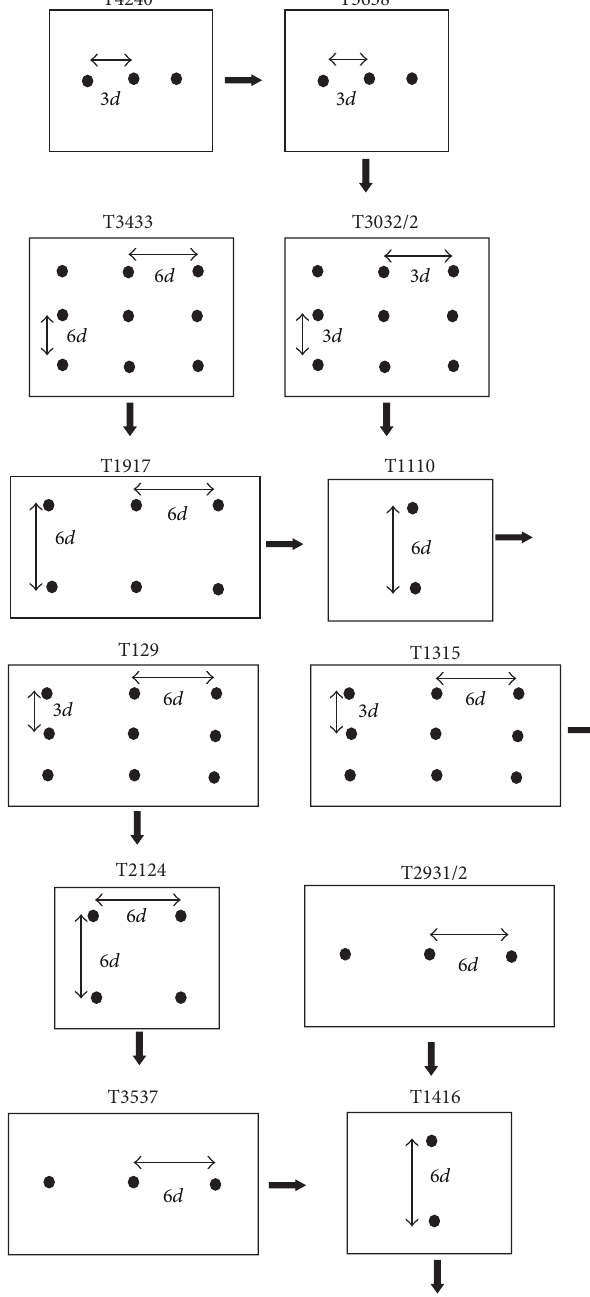
Figure 3: Pile group configurations and pile spacing ratio ( ↑ is the lateral loading